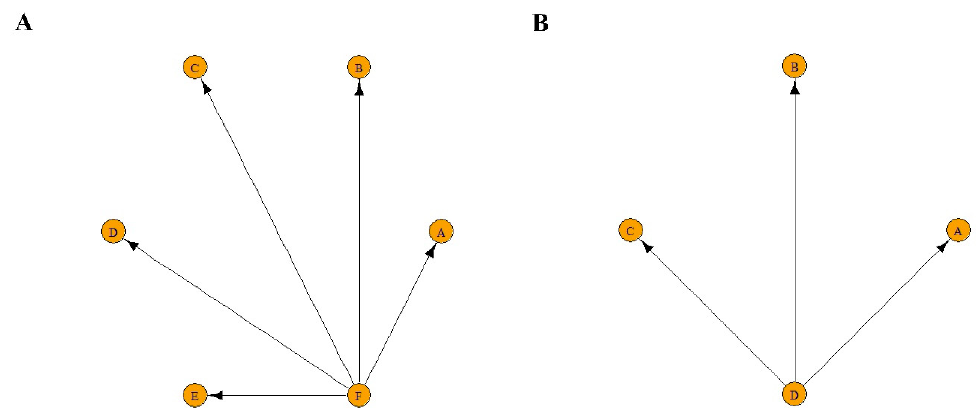
Figure 5. Network geometry of connected network of studies. Circles represent the regimen as a node in the network. Lines represent direct comparisons using studies. Each regimen was compared based on the effect of the control (no instillation). ( A ) All studies. A: Mitomycin C (MMC) 20 mg + Ara-C 200 mg (maintenance). B: MMC 10 mg (induction). C: Epirubicin 20 mg (induction). D: MMC 40 mg (single instillation). E: Pirarubicin 30 mg (single instillation). F: Control (no instillation). ( B ) Prospective controlled trials. A: MMC 20 mg + Ara-C 200 mg (maintenance). B: MMC 40 mg (single instillation).